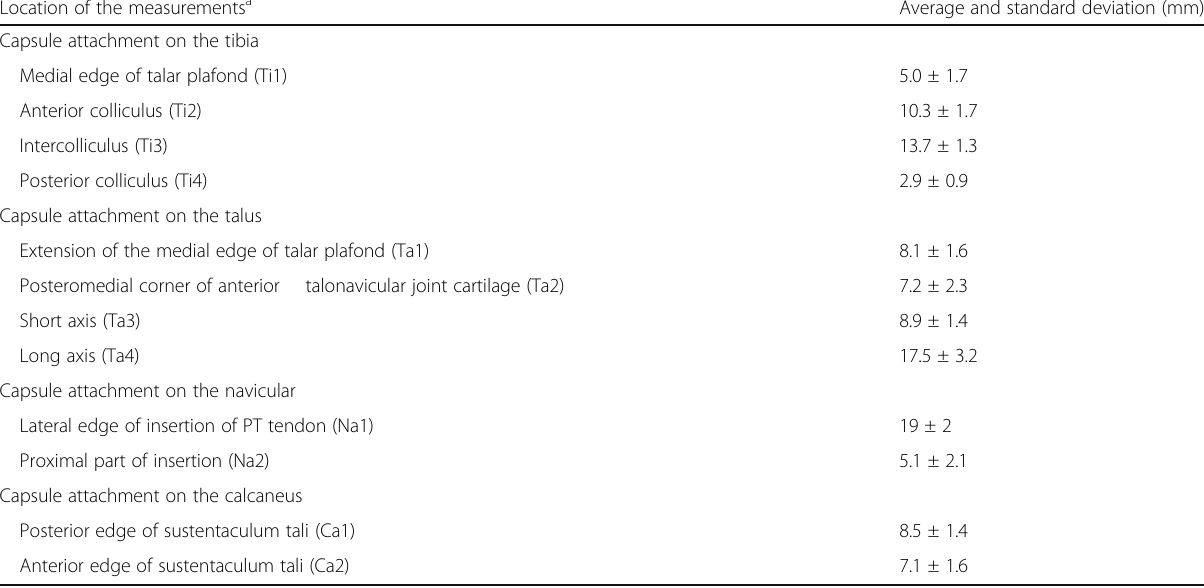
Table 1 Measurements of the width of the capsular complex Location of the measurements a Average and standard deviation (mm) Capsule attachment on the tibia